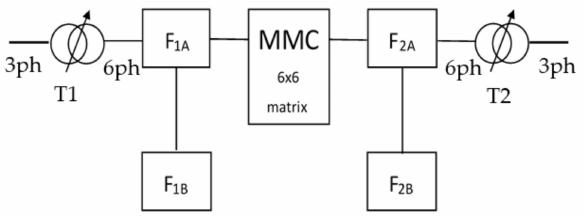
Figure 3. Proposed device: MMC—converter; T1, T2—transformers; F 1A , F 1B , F 2A , F 2B —series and parallel filter systems to support commutation and decrease harmonic